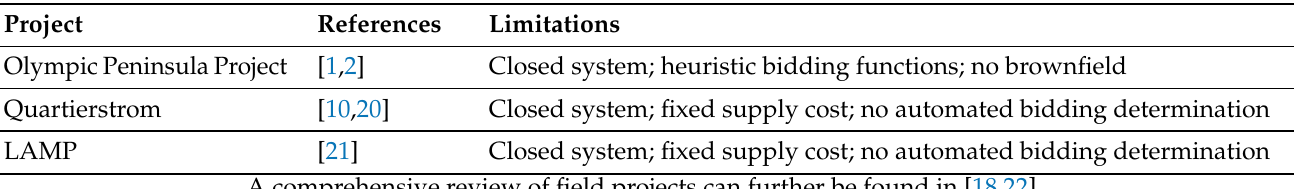
Table 2. Examples for operational field TS and local electricity